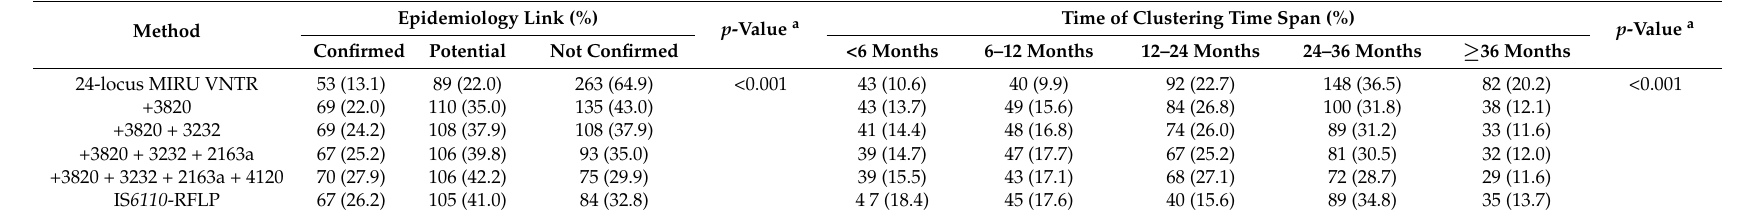
Table 4. Comparison of epidemiological links and clustering time span in different genotyping strategies.